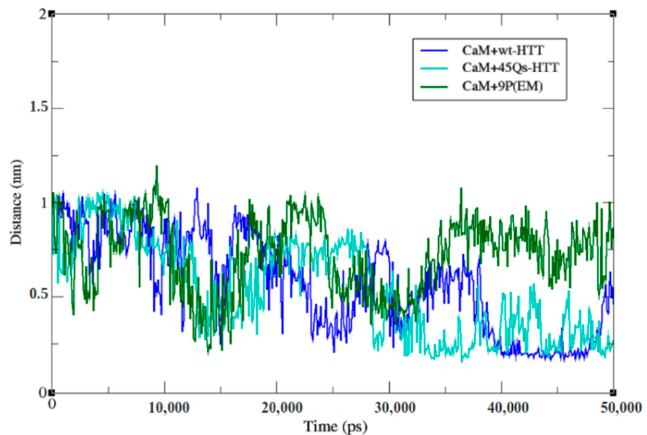
Figure 7. Minimum distance between the two lobes of the CaM structure.